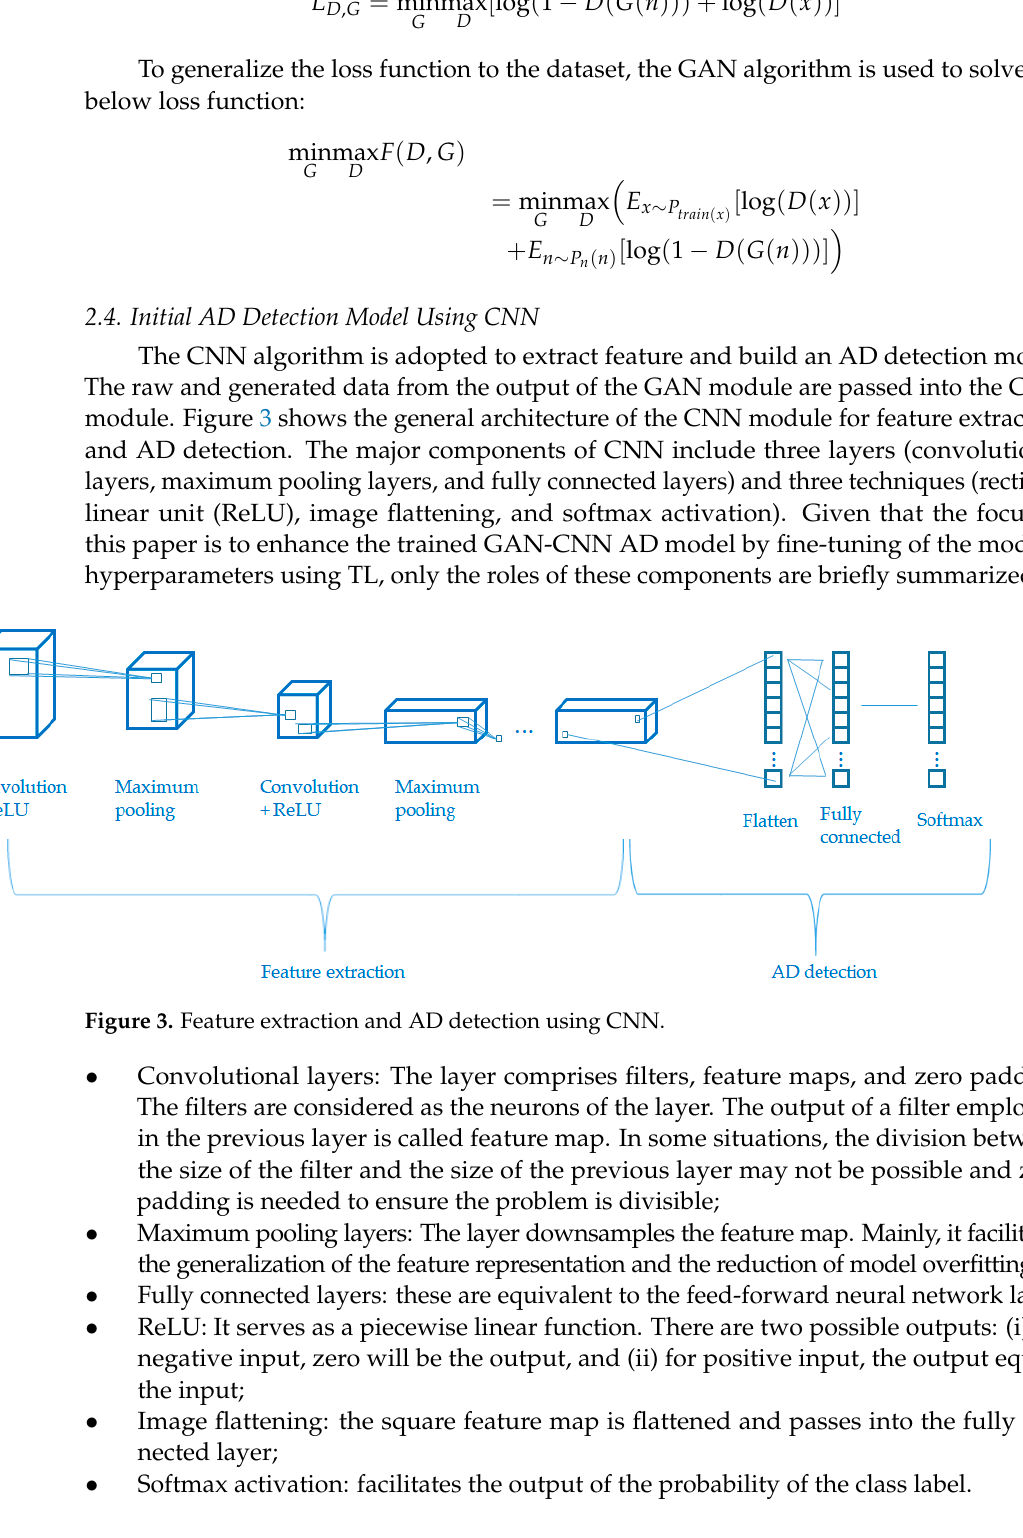
Figure 4. Two-tier transfer learning process with domain knowledge transfer to model for OASIS-1 by OASIS-2 and OASIS-3. The workflows of the transfer learning process are summarized as follows. • Step 1: begin with a trained GAN-CNN model in dataset 1;